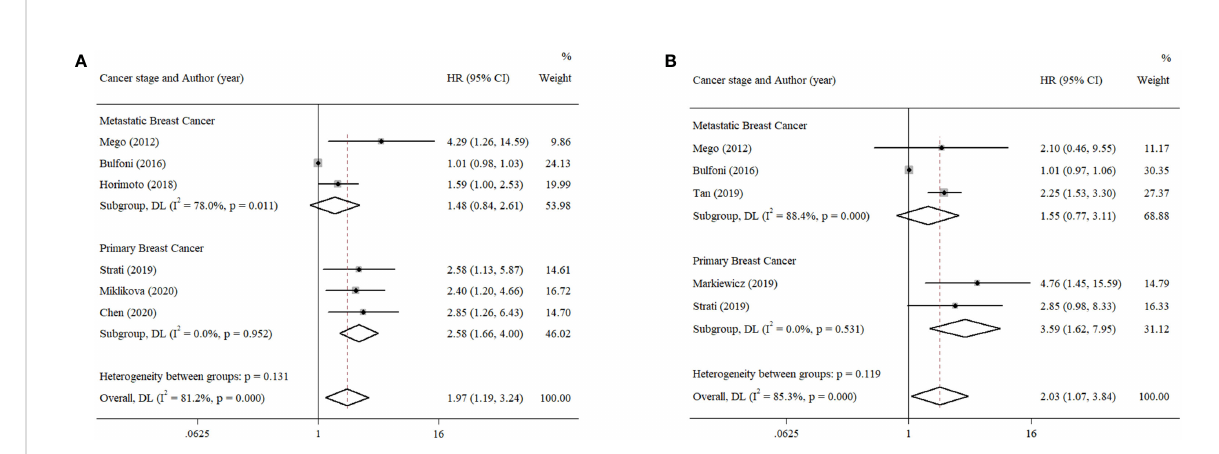
FIGURE 5 Subgroup analysis of the prognostic value of EMT-CTCs in different breast cancer stages. (A) Pooled HR for PFS and (B) pooled HR for OS.